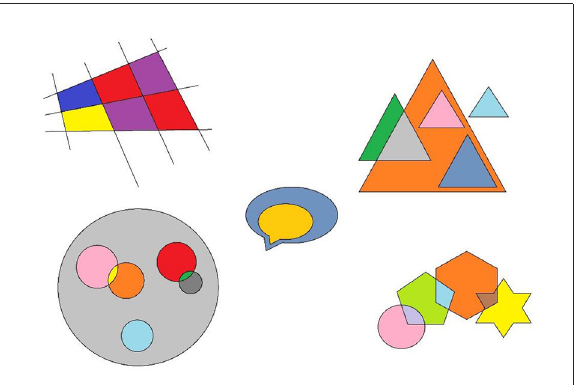
FIGURE5 Representation of the marker used to locate the condensate drain in augmented reality.